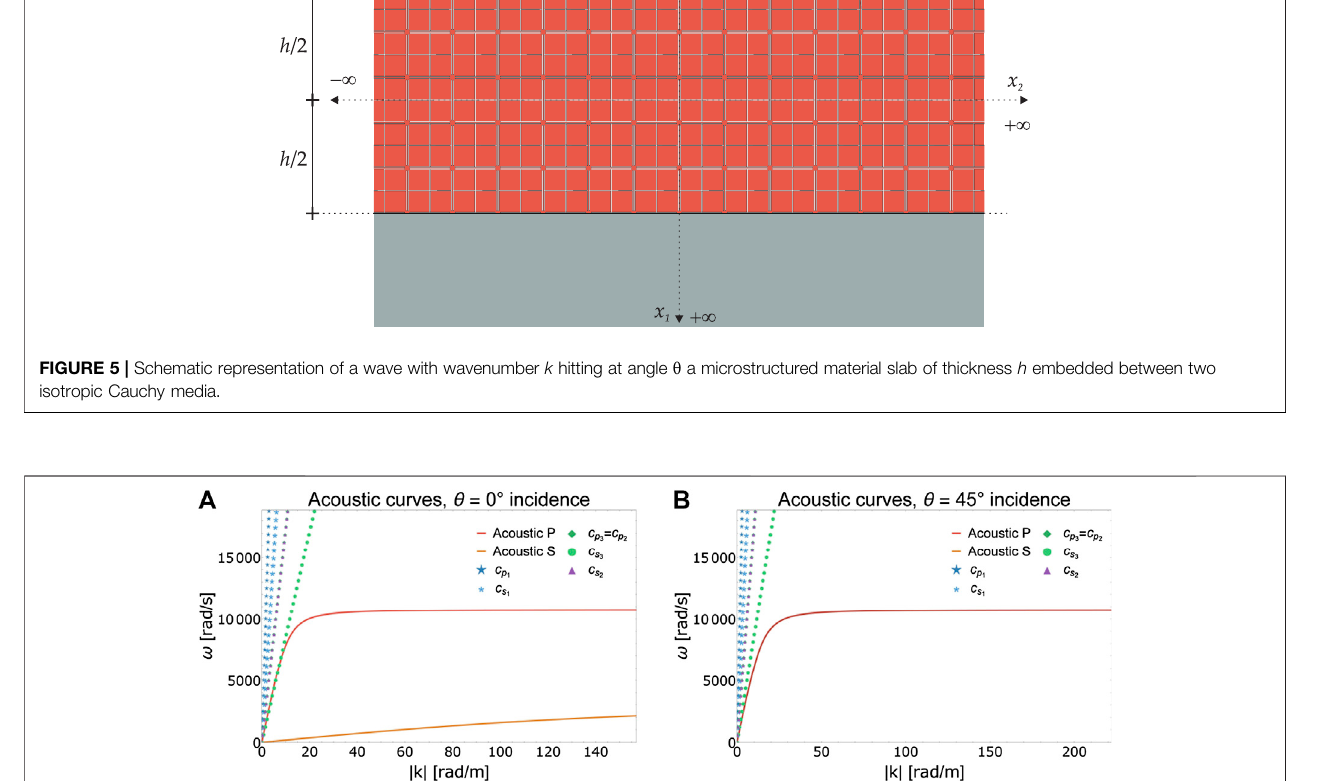
(cid:2) c p 3 , while a third one is almost superimposed since its value c s 2 is close to c p 2 and c p 3 (see Tables 5 2